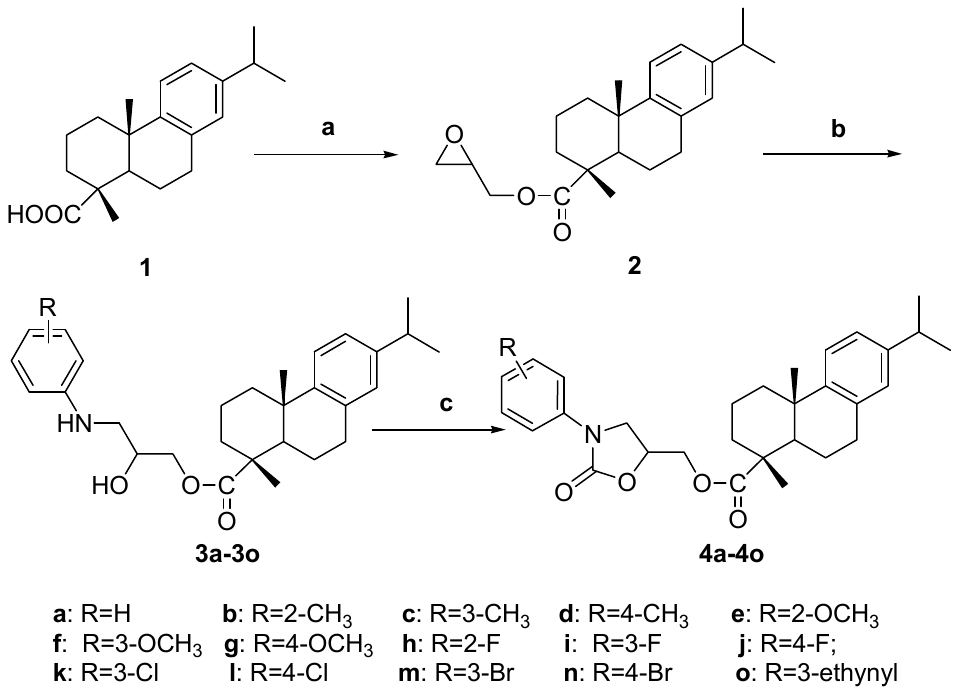
Scheme Scheme 1. Synthetic pathways for compounds 3a–o and 4a–o . Reagents and conditions: ( a ) epibromohydrin, acetone, 60 °C reflux 4 h; ( b ) aromatic primary amines, Zn(ClO 4 ) 2 ·6H 2 O, EtOH, 80